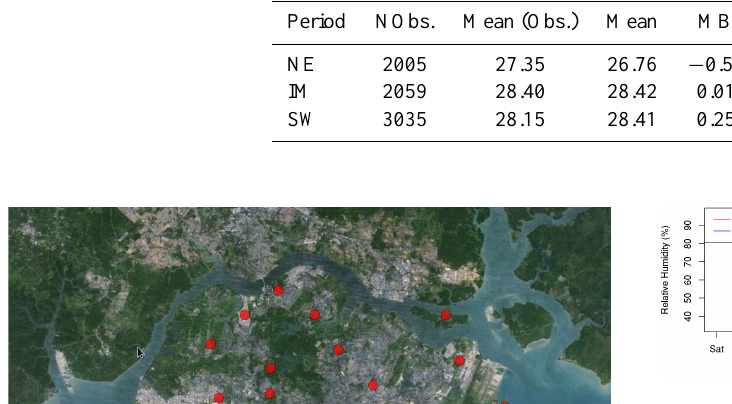
Figure 5. Same as Fig. 4 but for relative humidity.